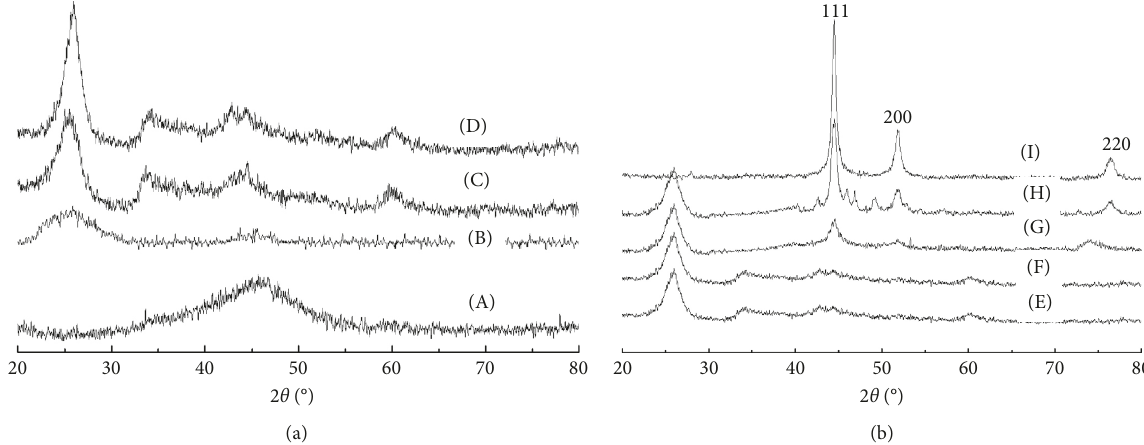
Figure 1: (a) XRD patterns of the amorphous alloy NiB and its supported catalyst: (A) NiB, (B) NiB/SiO (b) XRD patterns of NiB/CNTs catalyst treated at different temperatures: (E) 303K, (F) 573K, (G) 773K, (H) 873K, and (I)